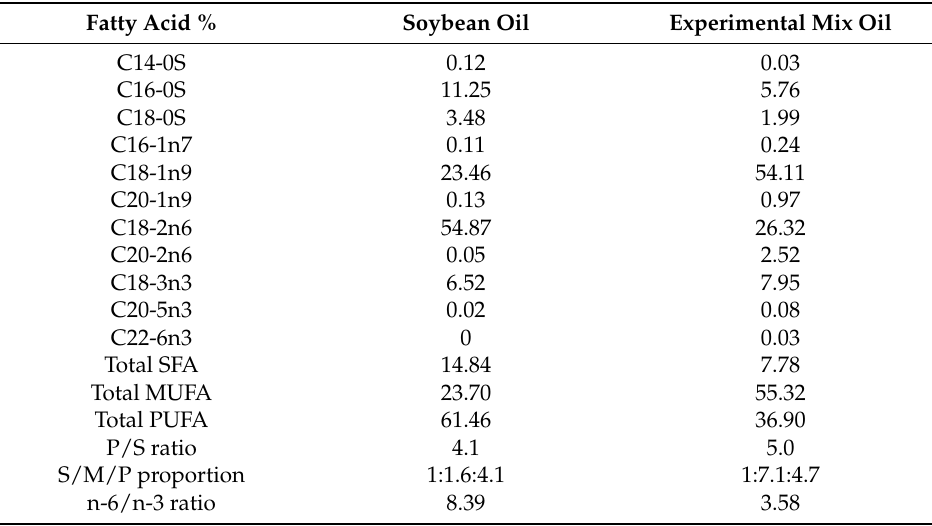
Table 2. The fatty acid composition of the